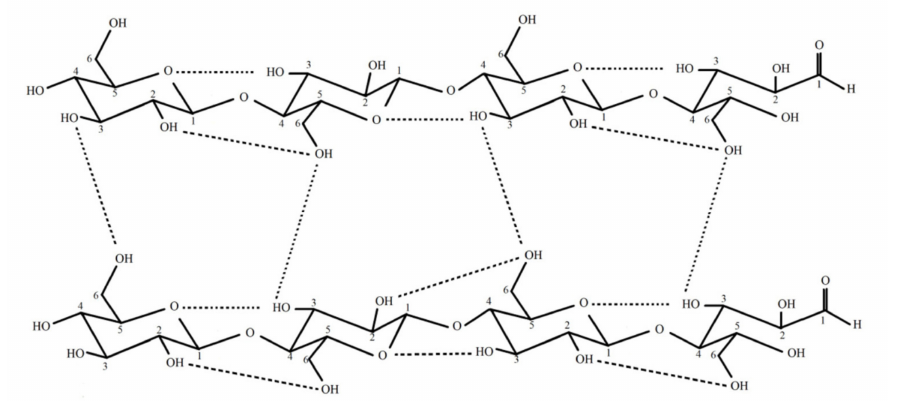
Figure 1. Inter and Intra hydrogen bonding between the bacterial cellulose (edited from Festucci- Buselli et al., 2007)) adapted from